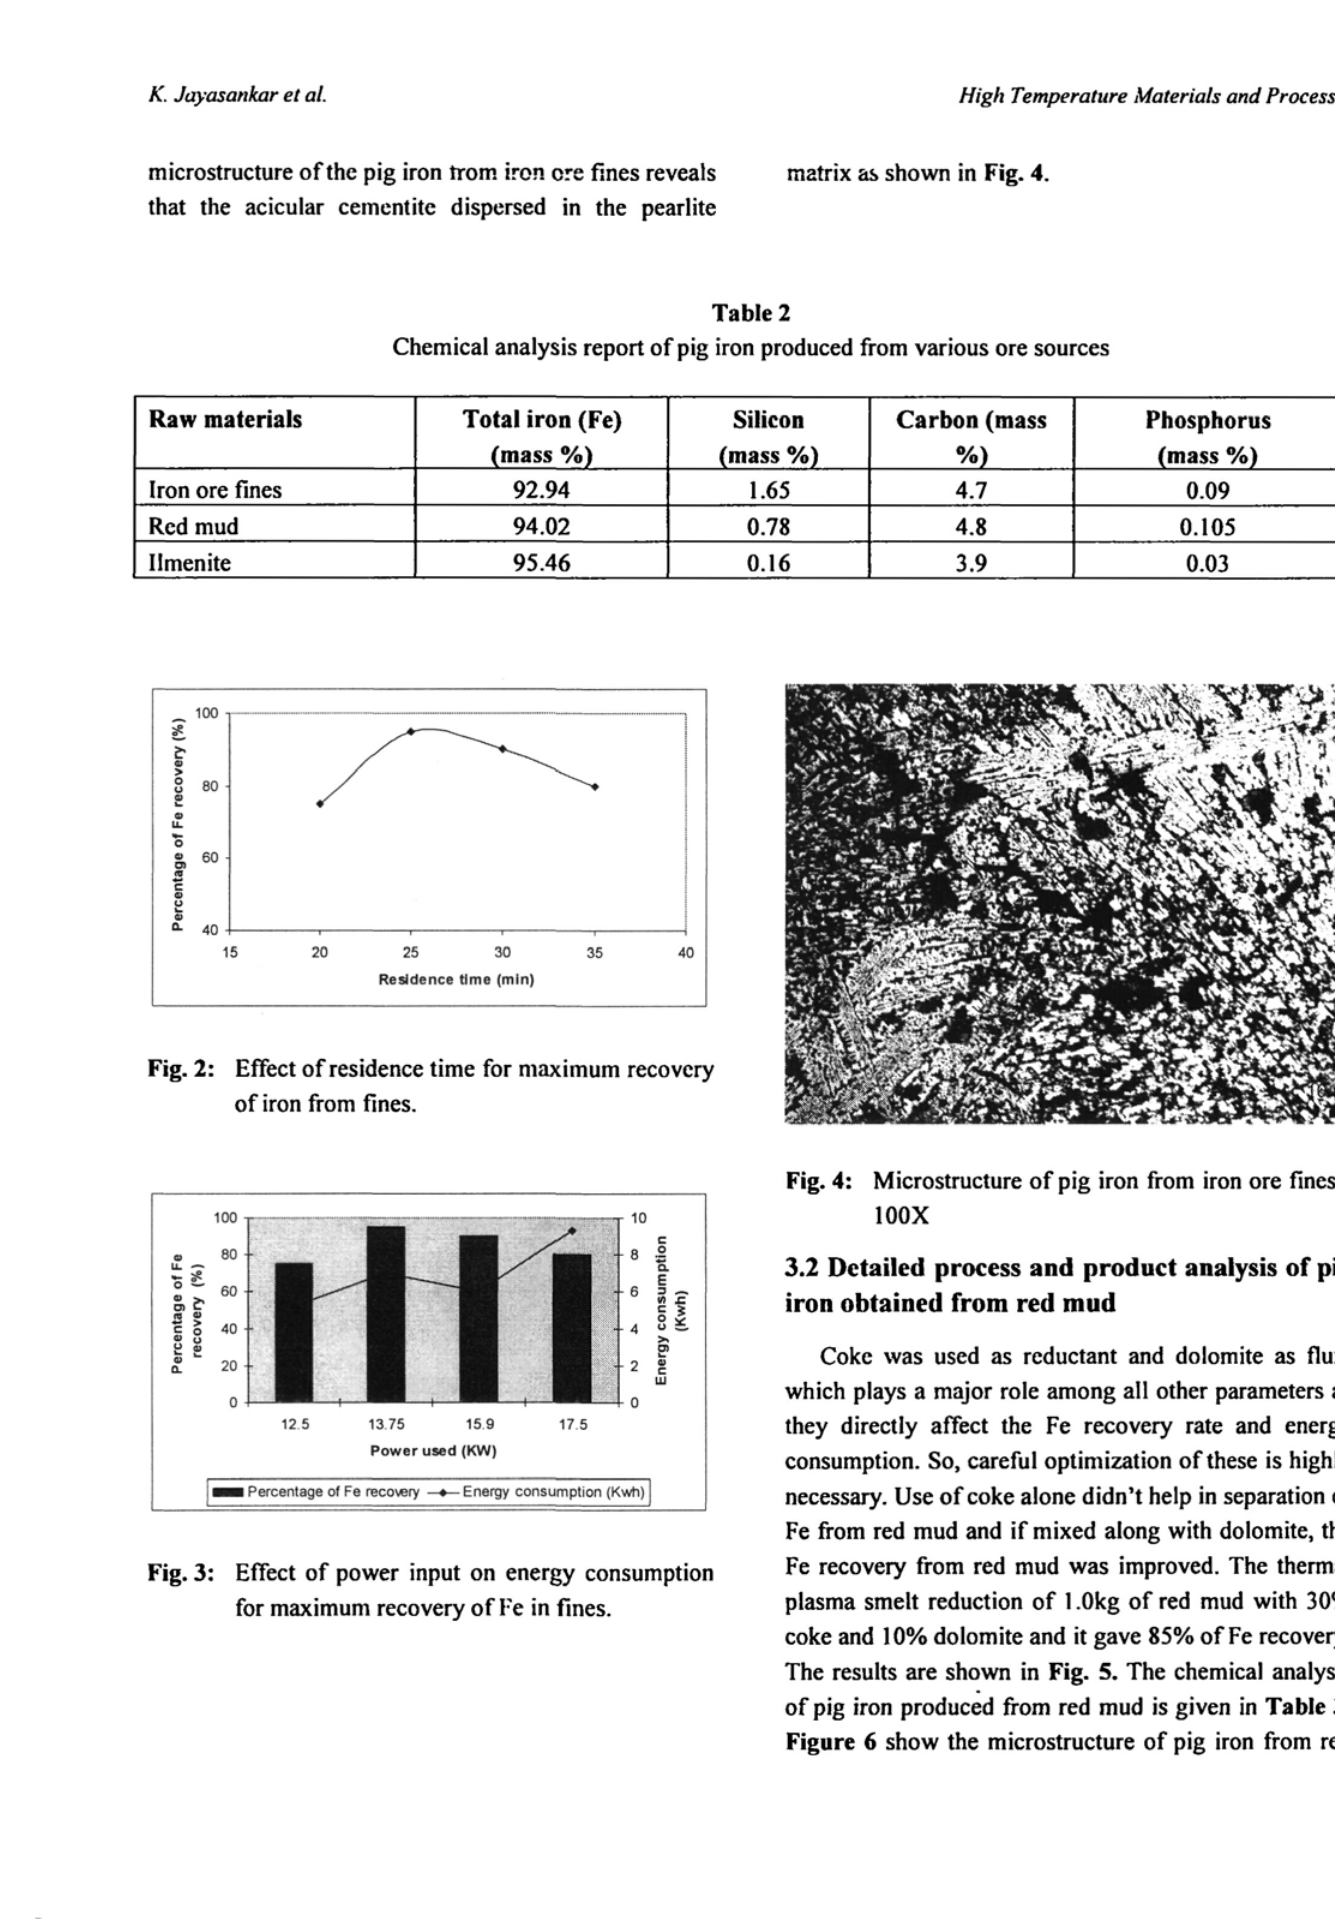
Fig. 4: Microstructure of pig iron from iron ore fines -